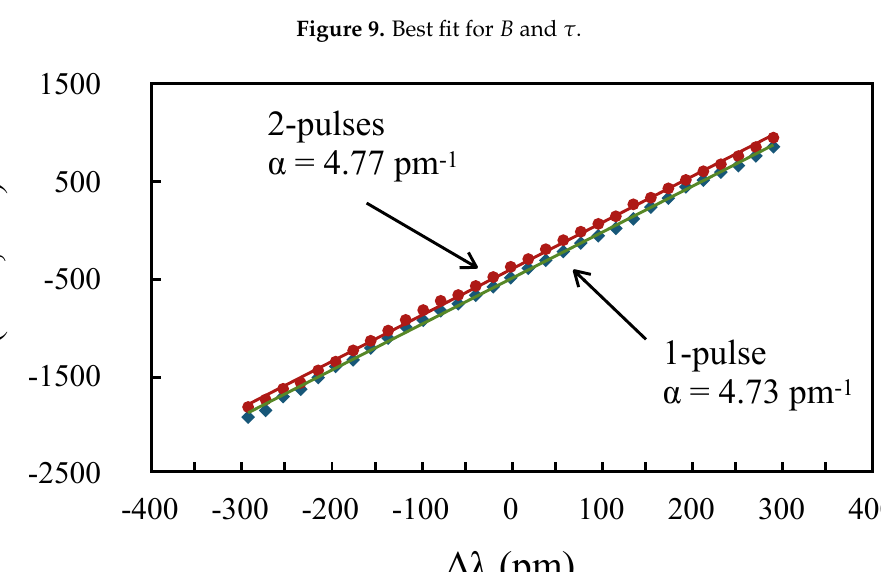
Figure 9. Best fit for B and τ .